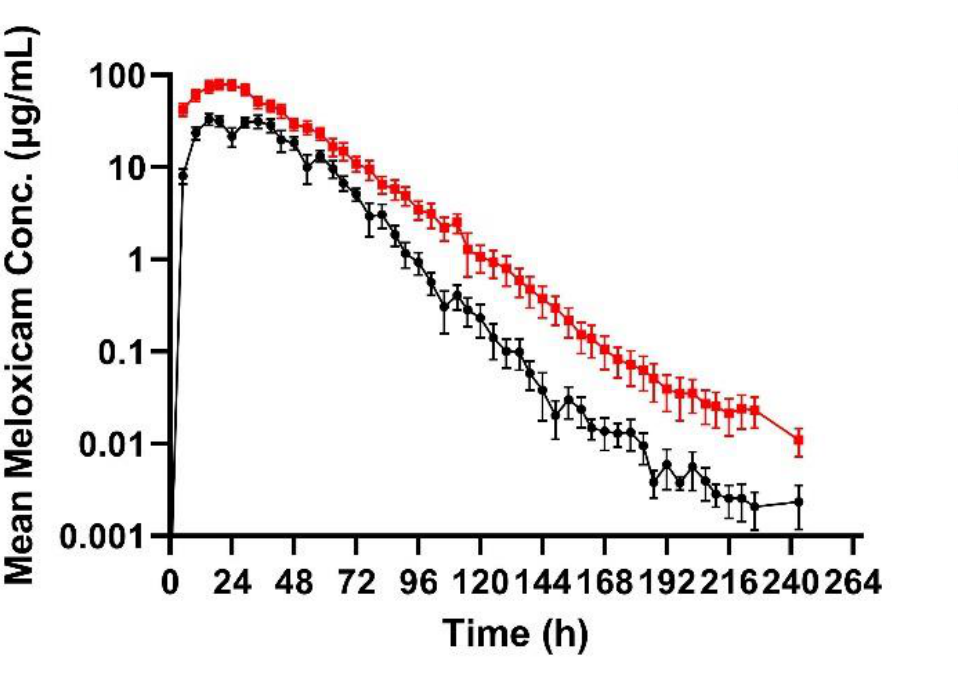
Figure 2. Mean (±SEM) milk and plasma concentrations of meloxicam following a single oral dose of 30 mg/kg in adult Holstein cows ( n = 5).